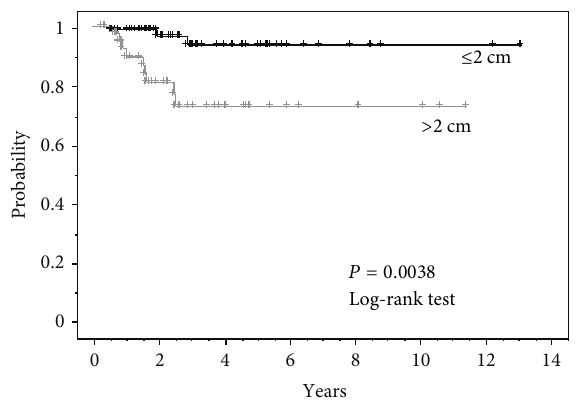
Figure 3: Local control for tumor diameter ≤ 2cm ( 𝑛 = 72 ) versus > 2cm ( 𝑛 = 44 ) 3 y. Local control rate ≤ 2cm: 93.4%, > 2 cm: 72.7%.